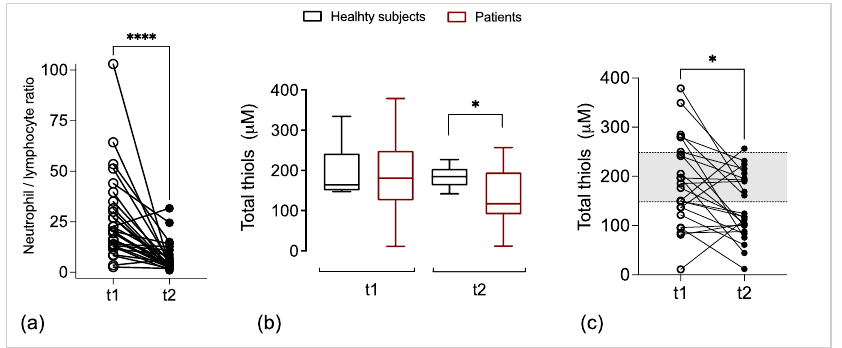
Figure 1. N/L ratio and thiol levels. ( a ) The N/L ratio before–after plots with the patients’ values at admission (t1) and two weeks later, during inpatient treatment (t2). ( b ) Total thiol levels in the sera of COVID-19 patients and healthy subjects at t1 and t2 using a commercial colorimetric assay. Box plots depict medians and quartiles. ( c ) Individual total thiol levels at t1 and t2; shaded areas flanked by dotted lines indicate the upper and lower limits of the 95% CI of the healthy subjects’ median thiol levels. * p < 0.05, **** p < 0.0001.